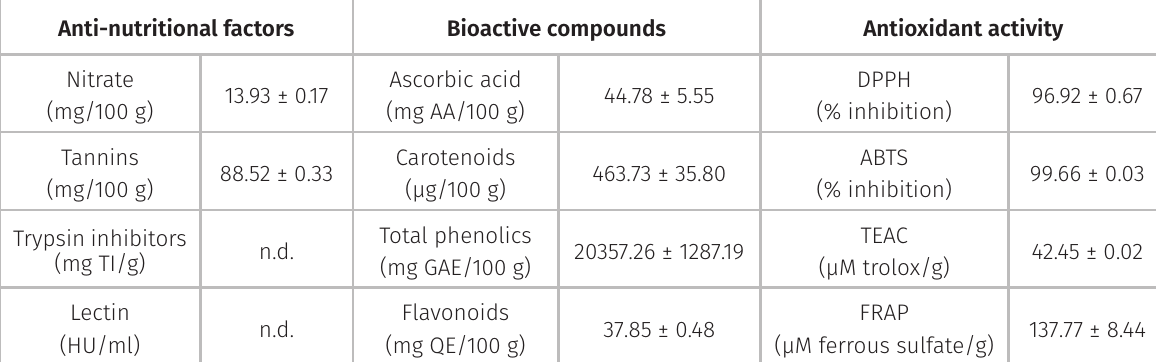
Table II. Anti-nutritional factors, bioactive compounds and antioxidant activity of umbu ( Spondias tuberosa Arr. Cam.) processing waste